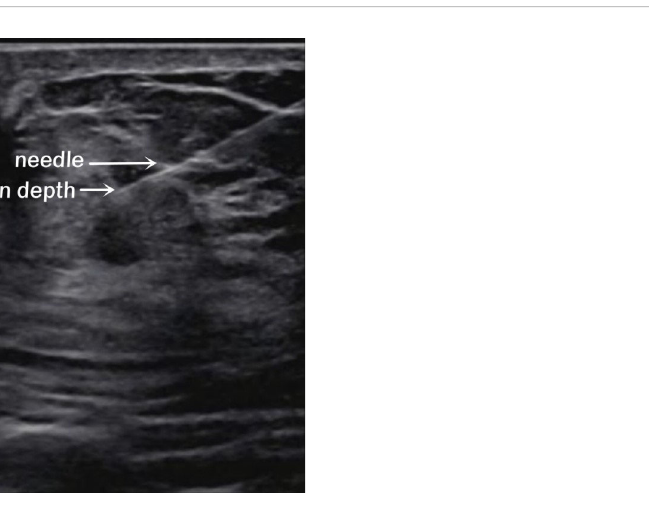
FIGURE 1 Ultrasound-guided intraglandular injection around the areola. The white arrows show the needle and the injection depth (6 o ’